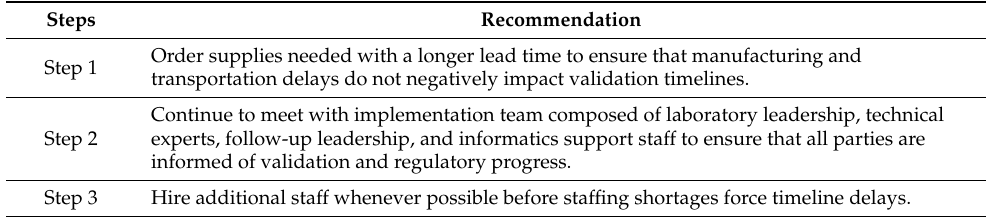
Table 6. Recommendations for implementing screening for a new disorder during a